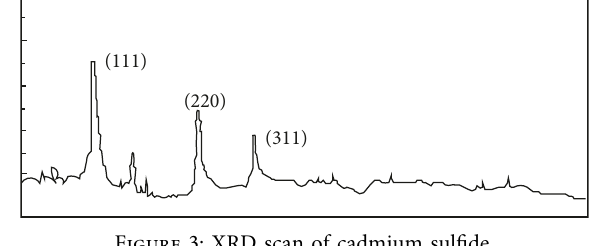
Figure 3: XRD scan of cadmium sulfide.